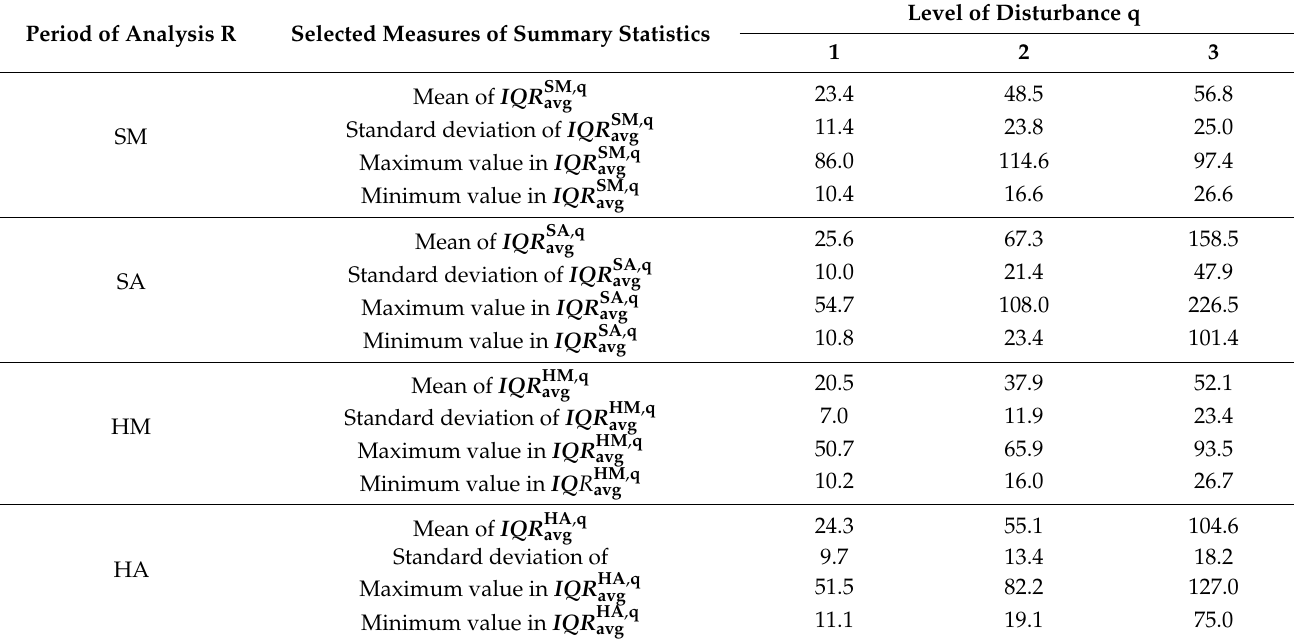
Table 3. Statistics for the set of sections assigned to the clusters in each of the analysis periods. Period of Analysis